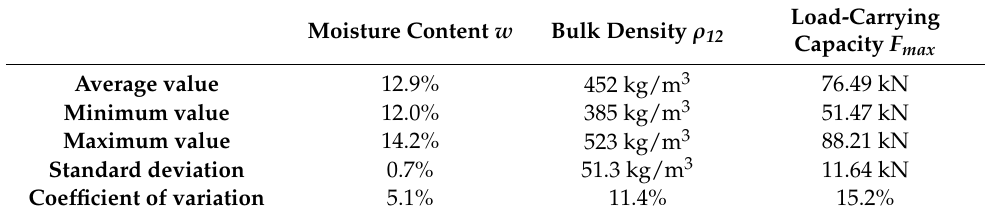
Figure 13. Load-deformation curves of H3 specimens. Table 7. Results of the experimental testing of H3 specimens.